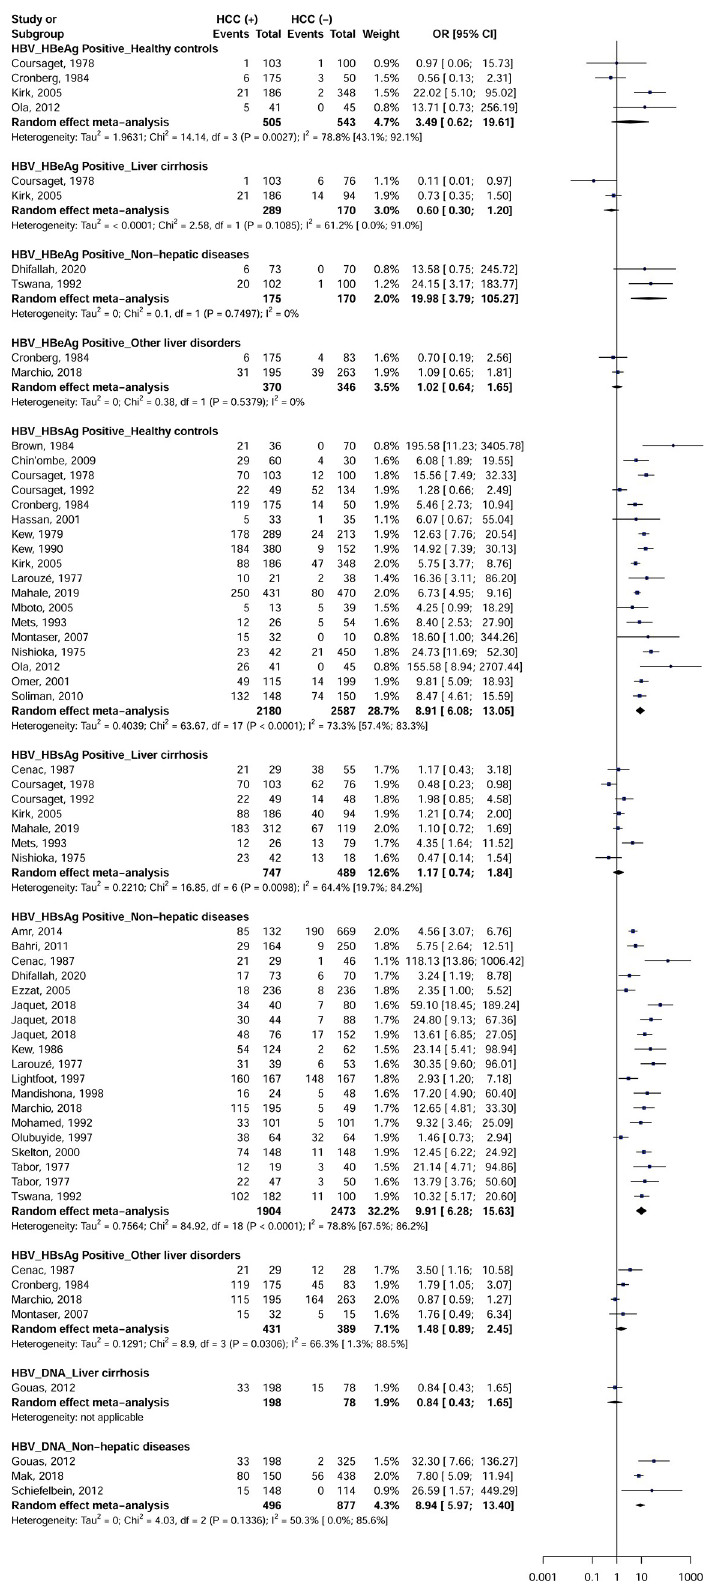
Fig 2. Association between Hepatitis B Virus infection and risk of hepatocellular carcinoma in Africa. https://doi.org/10.1371/journal.pone.0262903.g002 PLOS ONE | https://doi.org/10.1371/journal.pone.0262903 January 21,